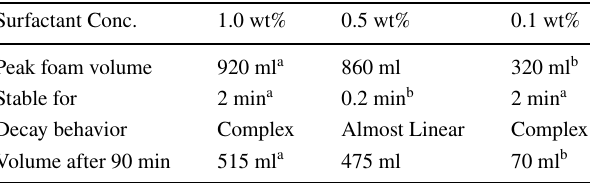
Table 10 Summary of modified bulk foam stability test for the effect of surfactant concentration